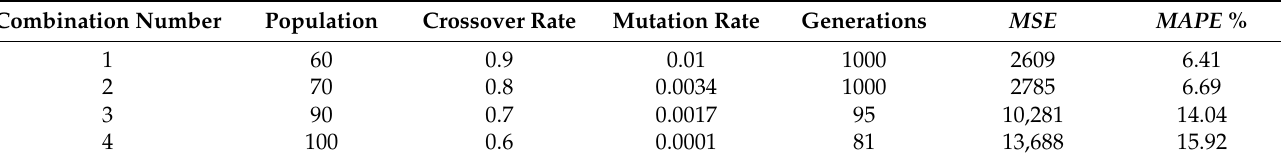
Table 5. GA-ANN’s parameters and the according performances during Table 5. GA- ANN’s parameters and the according performances during training.